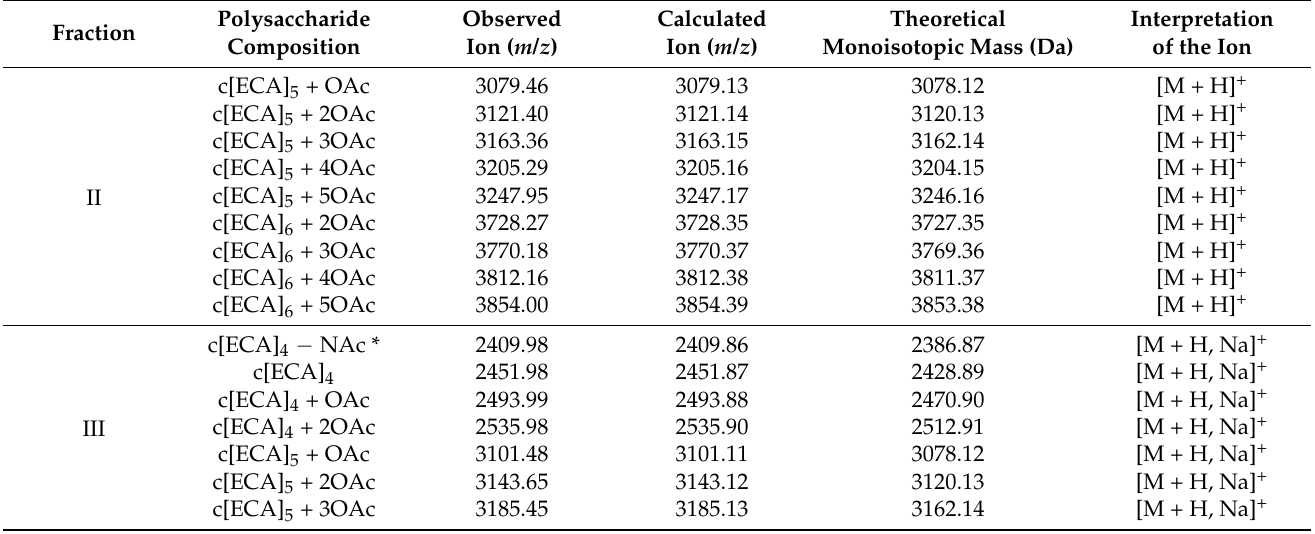
Table 3. Interpretation of main ions observed in fractions II–III from E. coli K12 supernatant (MALDI-TOF MS, positive ion